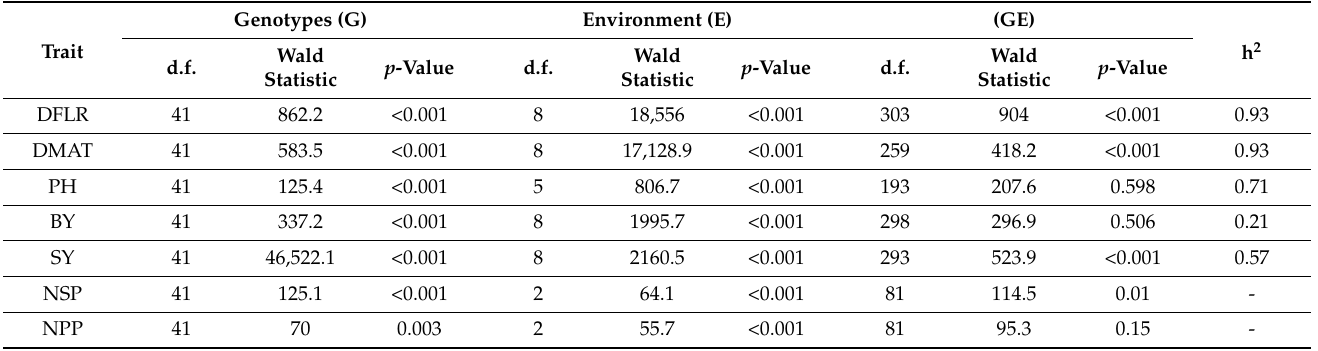
Table 1. Combined analysis for detecting Wald statistics and differences among genotypes, en- vironments, and genotype–environments interaction (GE) and narrow sense heritability (h 2 ) for phenological and agronomic traits for the validation trials at Marchouch in 2015/16 and 2016/17 and Terbol in 2018/19.